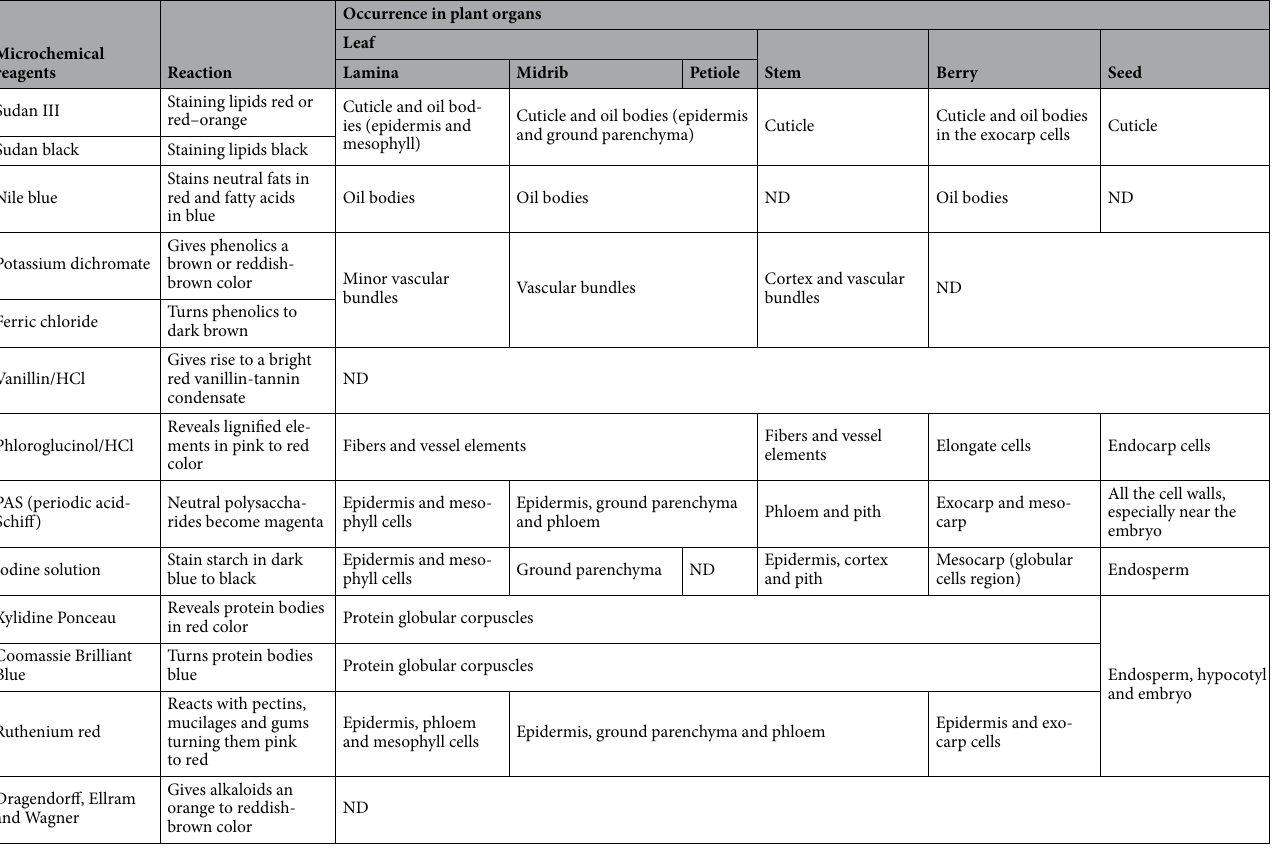
Table 1. Results of microchemical tests with V. album subsp. album . ND not